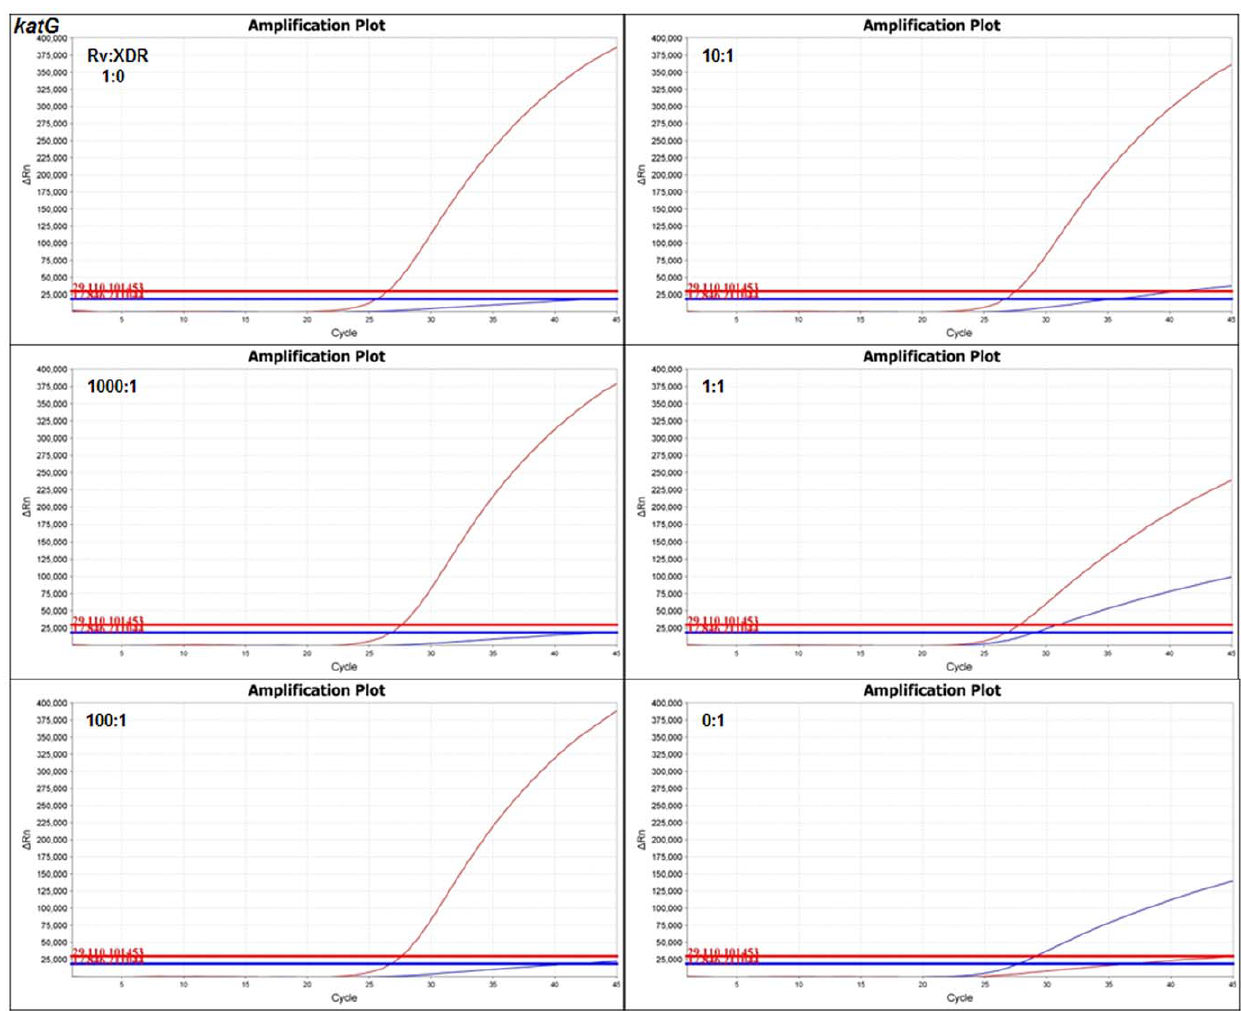
Figure 2. Real-time PCR of undiluted DNA. The undiluted DNA of each H37Rv:XDR-TB mixture underwent real-time PCR for each gene with both probes. katG is shown, with detection of mutant sequence (blue trace) at H37Rv:XDR-TB mixtures of 0:1, 1:1, and late detection at 10:1. Detection of wild-type sequence occurred at all H37Rv containing mixtures. qPCR thresholds were set per Figure 1 (red and blue horizontal lines for wild-type and mutant fluorophores, respectively). Similar results were found for other genes (see Figure S1 for rpoB , gyrA , rrs ).